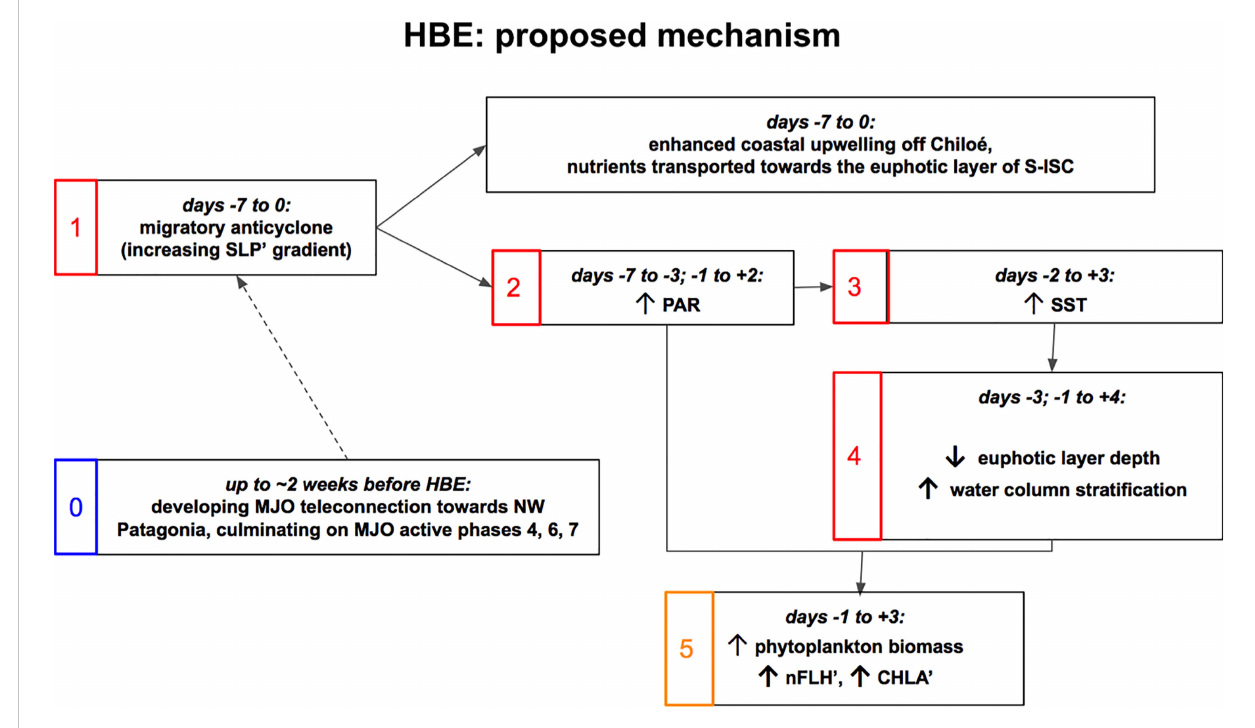
FIGURE 12 Schematic mechanism proposed for the average signal of the occurrence of HBE in association with the atmospheric forcing imposed by a migratory anticyclone over the study area. For complementary spatio-temporal information, please refer to the Hovmöller diagrams of Figure